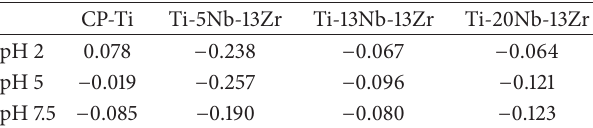
Table 1: OCP values (in V/SCE) measured after 3h exposure in Ringer’s solution of pH 2, 5, and 7.5 at 37 ∘